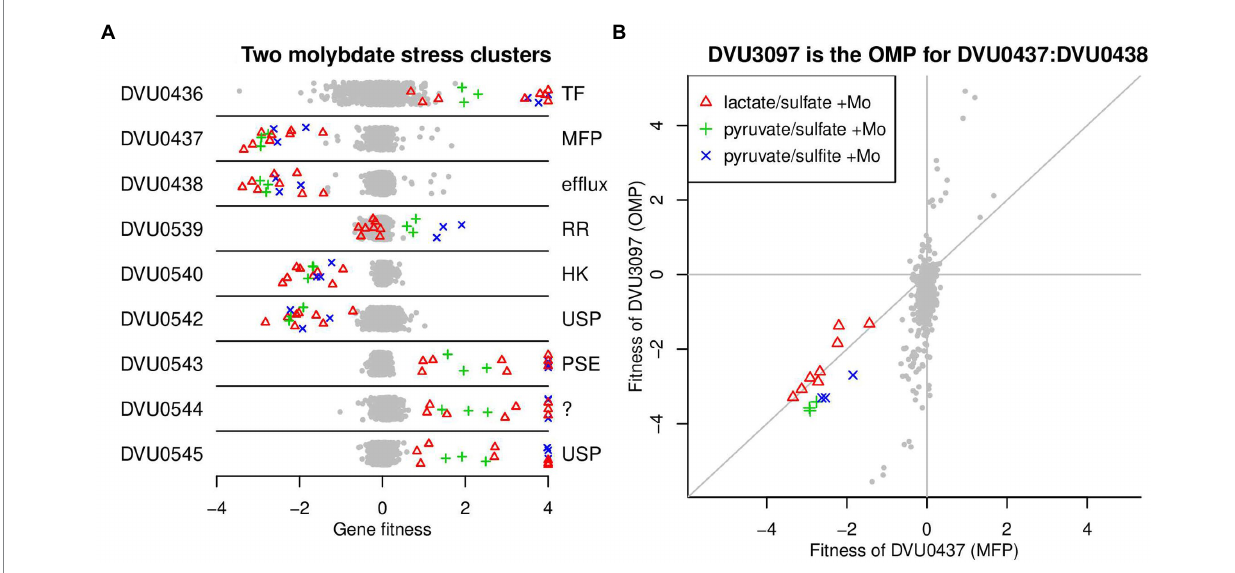
FIGURE 7 Selected genes with specific phenotypes during molybdate stress. (A) Two clusters of genes involved in molybdate stress. Each point represents the fitness of that gene in a genome-wide assay ( x -axis). Values above +4 are shown at +4. The y -axis is random. (B) Comparison of fitness patterns for the membrane fusion protein DVU0437 and the outer membrane protein DVU3097. In both panels, experiments with added molybdate (0.1 mM) are highlighted with the same color coding (see panel B legend). 4 of the 8 experiments with lactate/sulfate media and added molybdate also had tungstate added (at 0.5 or 2.0